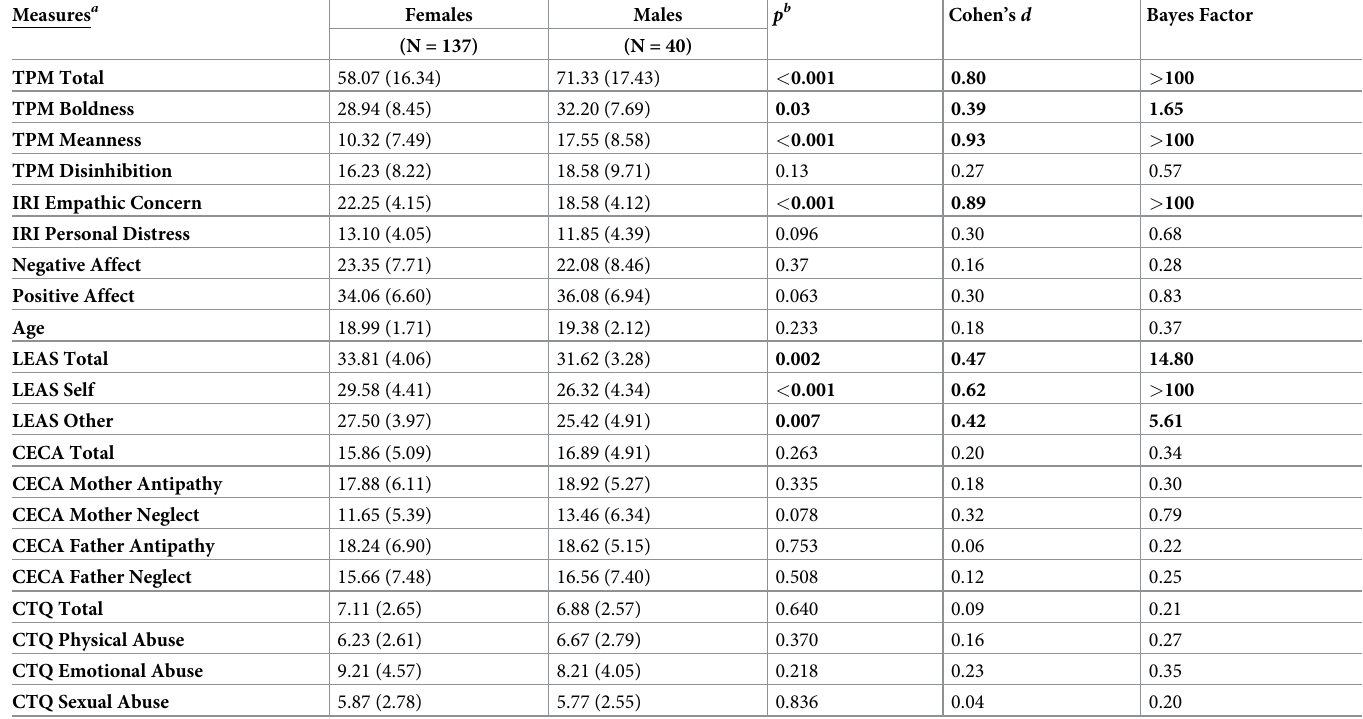
Table 1. Summary statistics (mean and SD) for study measures by sex.